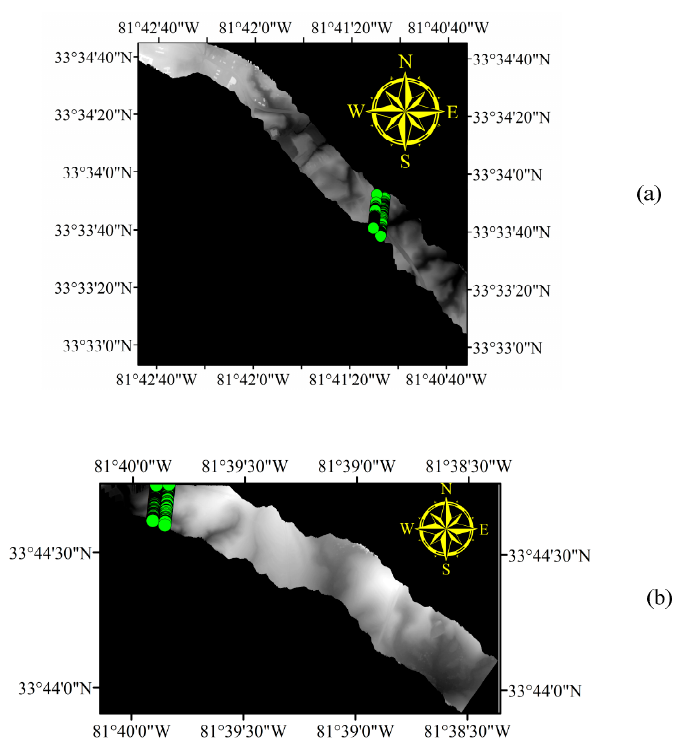
Figure 5. Two experimental data ( a , b ) sets in study area. The green dots on this figure are ATLAS footprints. The gray block is the G-LiHT Digital Terrain Model (DTM). footprints. The gray block is the G-LiHT Digital Terrain Model